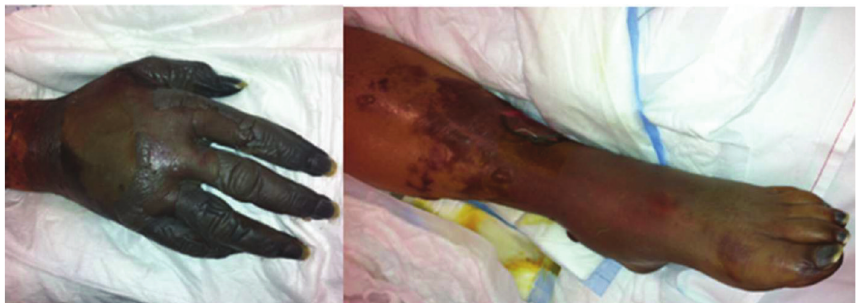
Figure 1: Aspect of the symmetrical peripheral gangrene affecting both arms and legs after 1 month in the ICU.